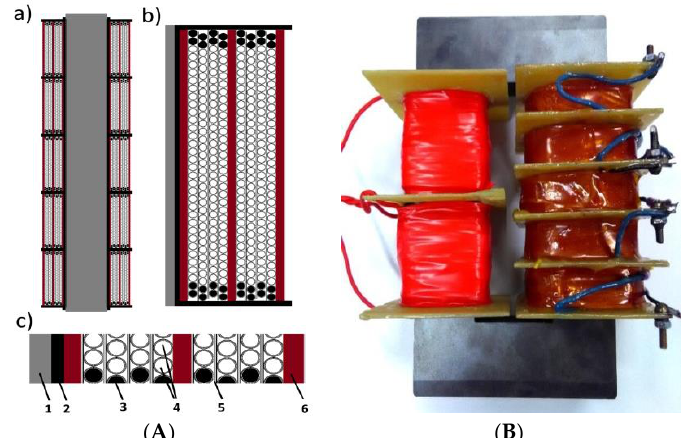
Figure 24. ( A ) Schematic structure of the secondary winding of the high frequency transformer, where a) total windings’ cr oss-section with the core, b) enlarged section fragment with one coil, c) layer diagram, where 1 — core, 2 — carcass 3 — insulation coil, 4 — winding wire, 5 and 6 — interlayer insulation, ( B ) – picture of the HF transformer